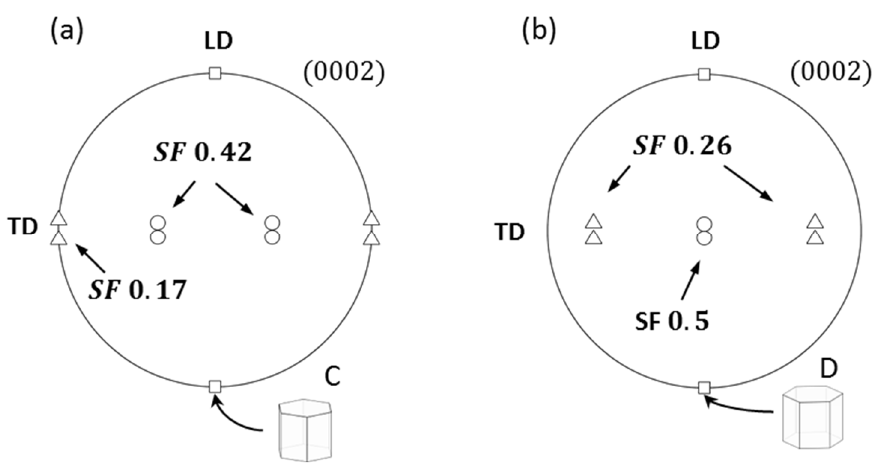
Figure 21. Basal pole figures showing the initial orientations ( a ) C and ( b ) D depicted by squares as (cid:8) (cid:9) well as the corresponding 1012 extension twin variants (triangles and circles). Circles indicate the experimentally observed high Schmid factor (SF) twin